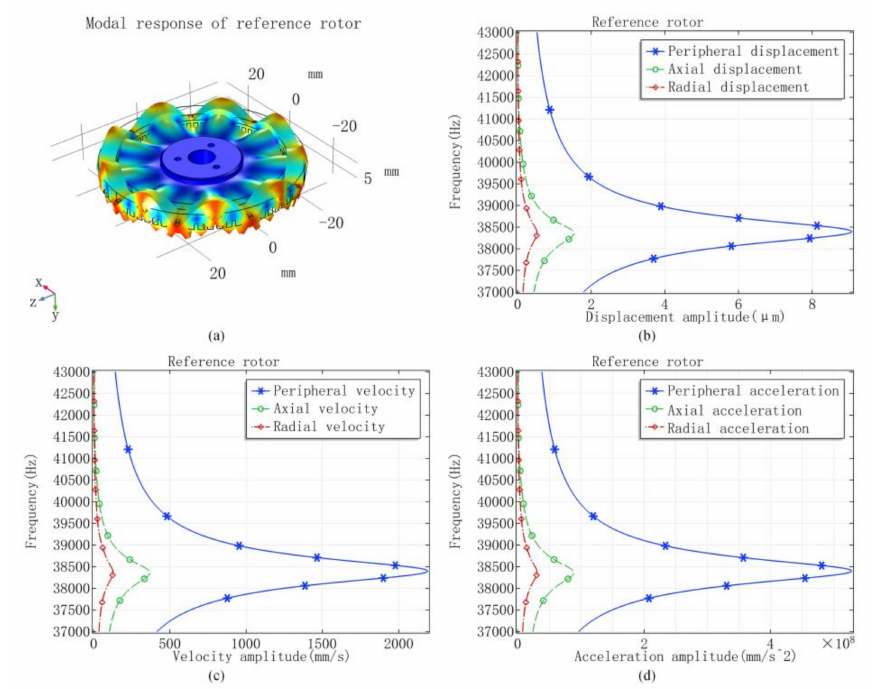
Figure 6. Amplitude response of reference rotor in the peripheral, axial and radial directions. ( a ) Modal response nephogram of reference rotor. ( b ) Displacement amplitude versus sweeping drive frequency. ( c ) Velocity amplitude versus sweeping drive frequency. ( d ) Acceleration amplitude versus sweeping drive frequency.